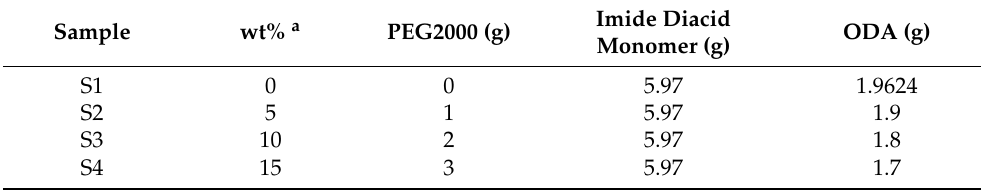
Table 2. The synthesis of PAI-PEG composites with different amounts of PEG.